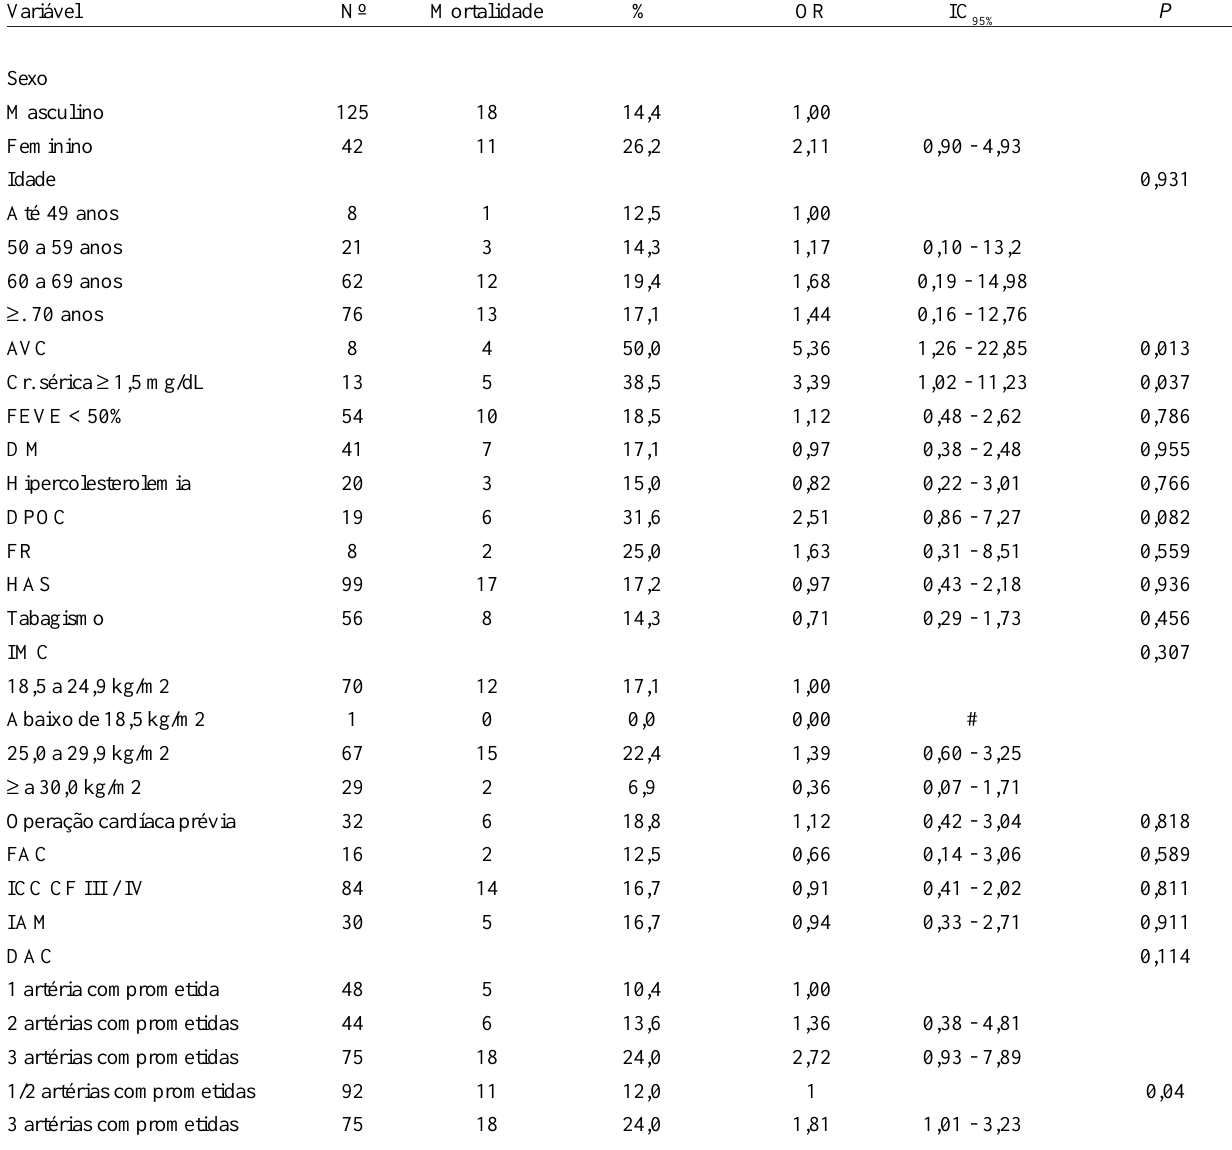
Tabela 6. Distribuição da mortalidade hospitalar do G2, em função dos dados pré-operatórios.